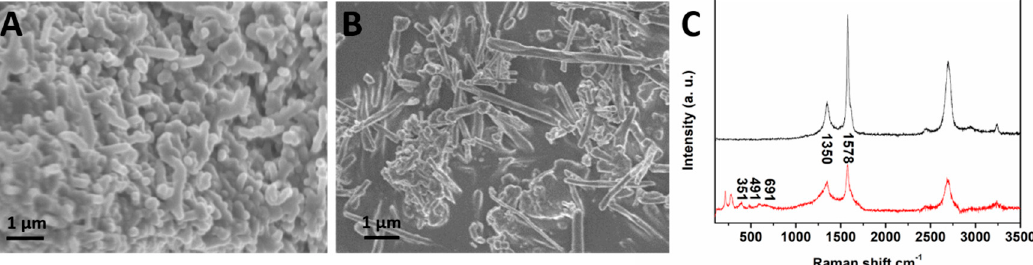
Figure 1. Typical scanning electron microscope (SEM) image of ( A ) carbon nanotubes (CNTs) and ( B ) magnetized carbon nanotubes (MCNTs); ( C ) Raman spectrum of shortened CNTs (black line) and MCNTs (red line).